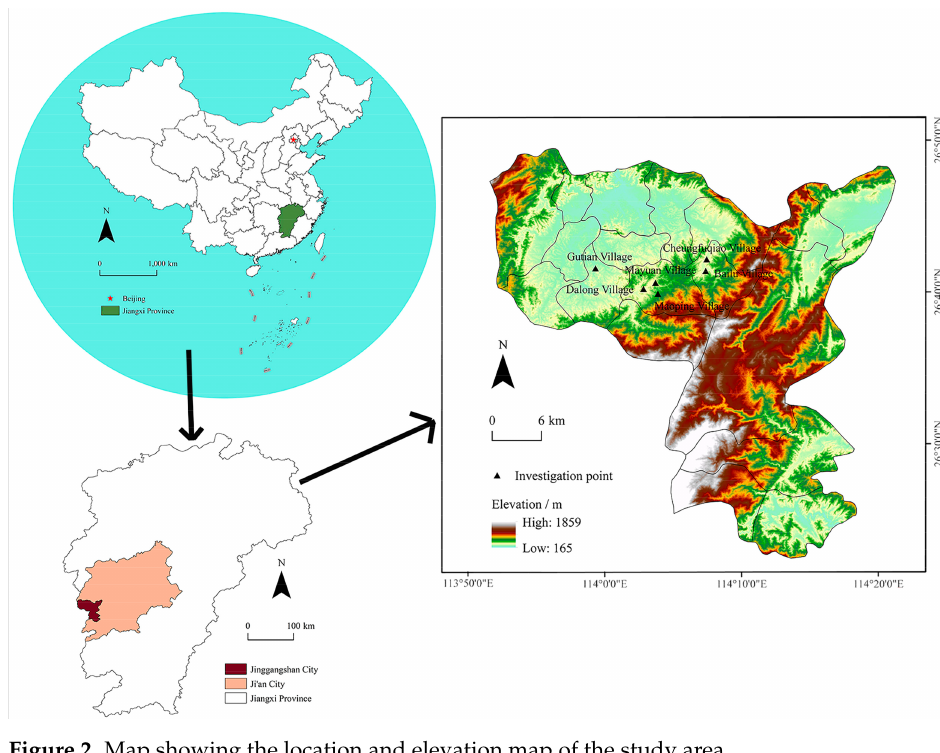
Figure 2. Map showing the location and elevation map of the study area.